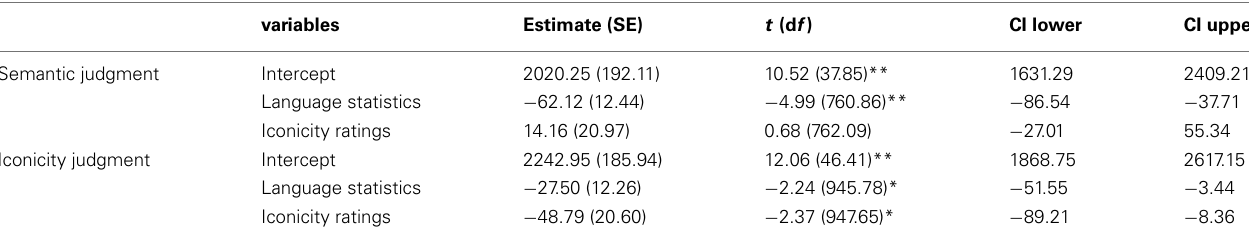
Table 1 | Regression coefficients for the semantic judgment and iconicity judgment RT